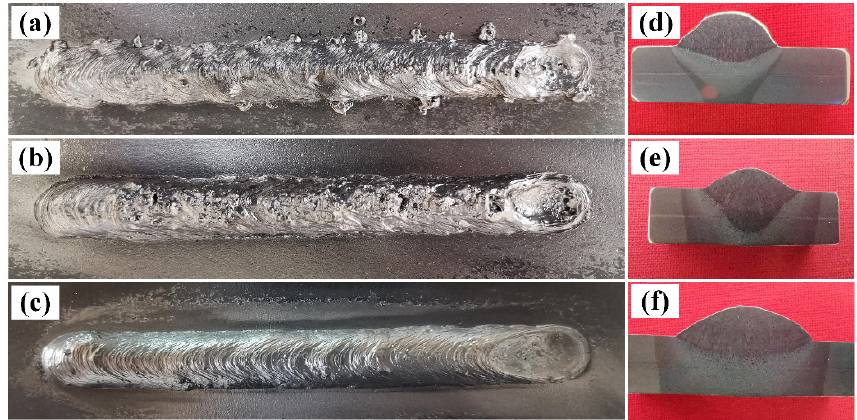
Figure 2. Bead-on-plate welds appearance and cross section of different welding. ( a , d ) UWW; ( b , e ) WG-USAW; ( c , f ) EP-USAW.